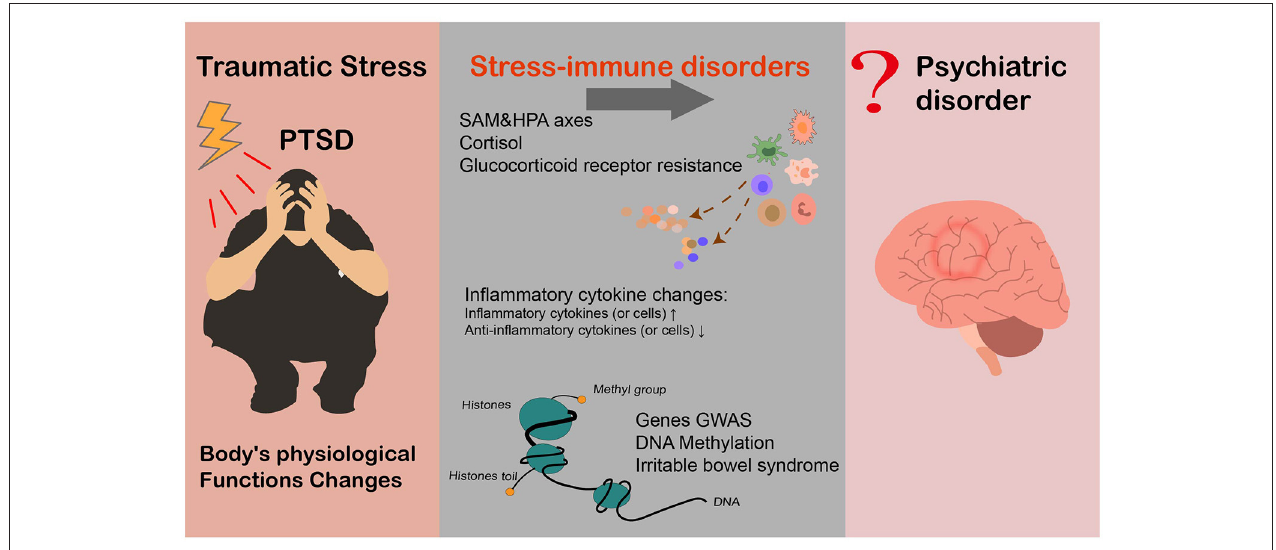
FIGURE 1 | The relationship between inflammation and